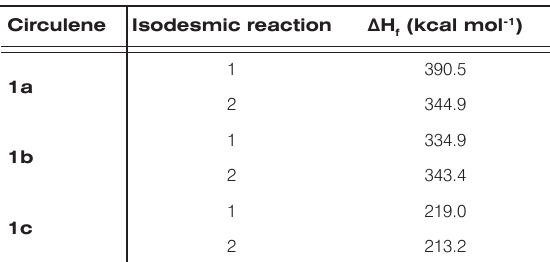
Table 1. Enthalpies of formation of compounds 1a to 1c (HF/6-311G(d,p) level of theory). Circulene